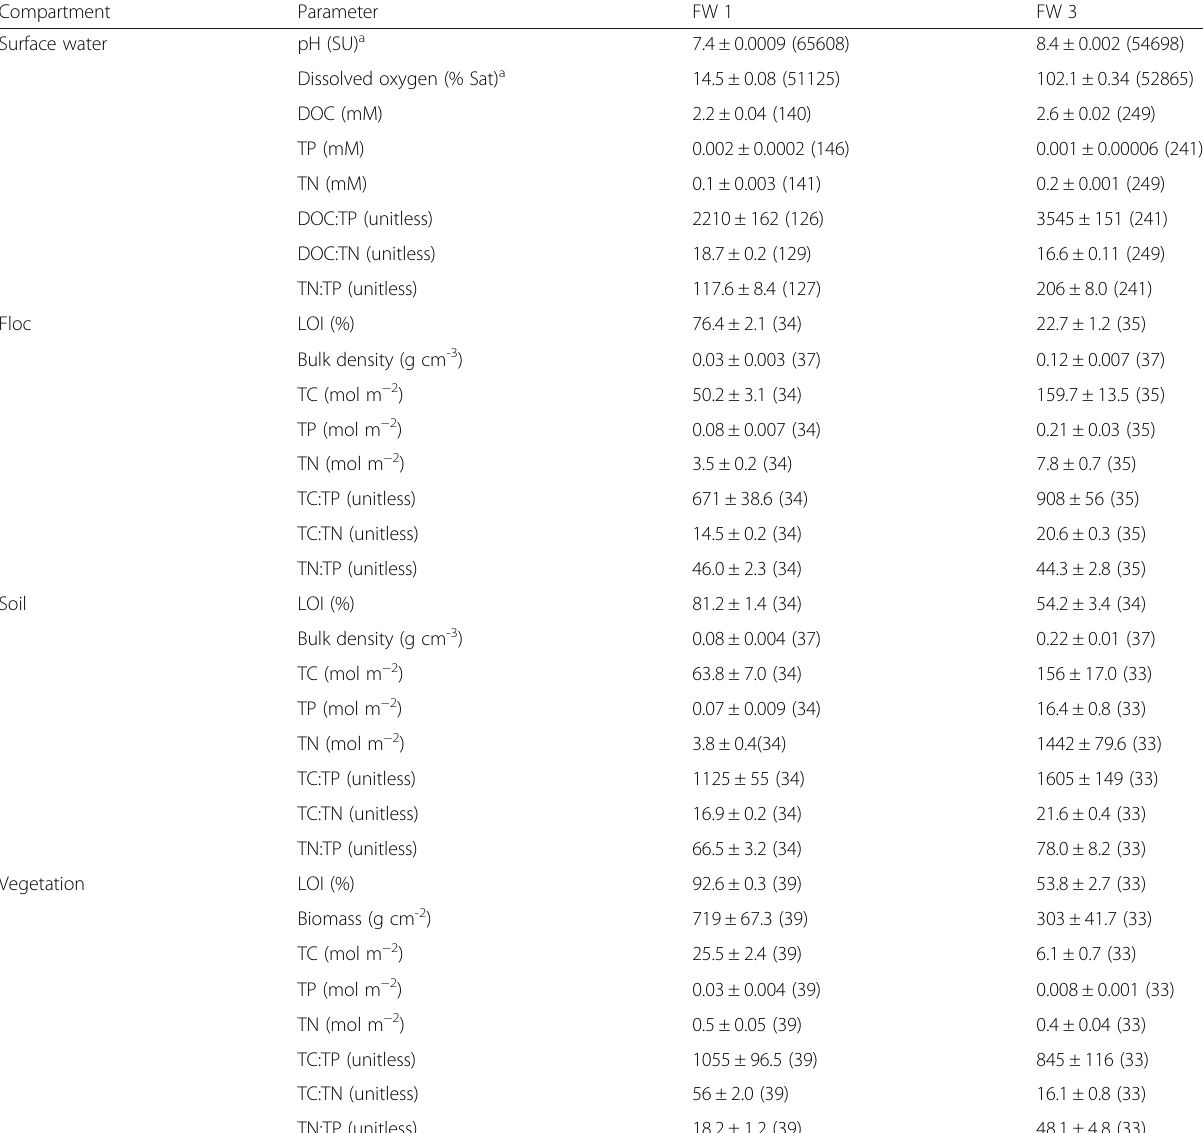
Table 1 Summary statistics for parameters and matrices used in this study of samples collected along the flow-ways 1 and 3 flow- path transect within Stormwater Treatment Area-2. Summary statistics expressed as mean ± standard error (sample size). Matrices include surface water, soil flocculent material, recently accreted soil, and living aboveground biomass of sampled vegetation. Stoichiometric ratios are expressed as molar ratios and are